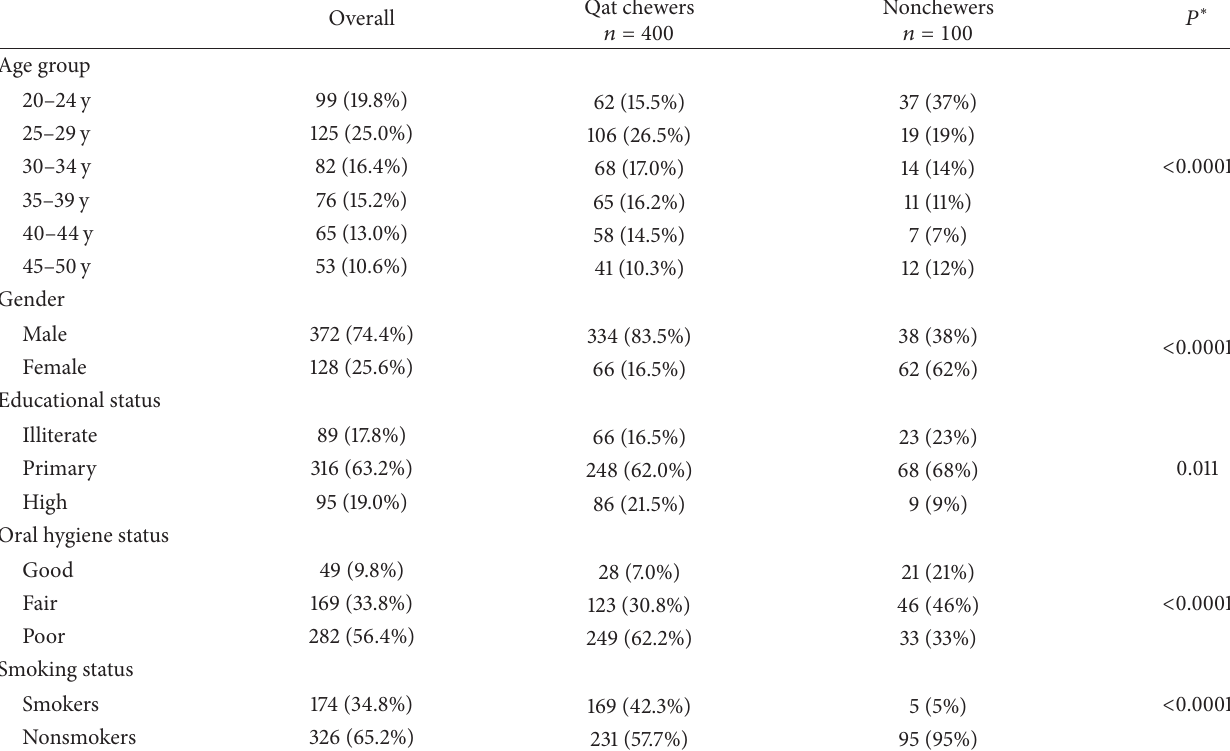
Table 1: Demographic data, oral hygiene, education level, and smoking status of both study